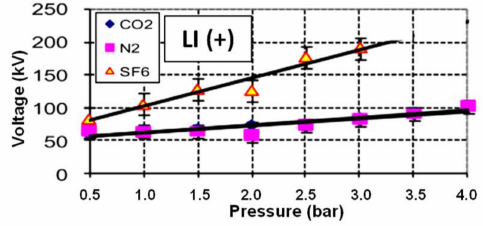
Figure 9. Comparison of breakdown voltages of the three investigated gases in sphere–sphere electrode arrangement for AC, negative DC, and positive LI voltages; electrode gap d = 10 mm.